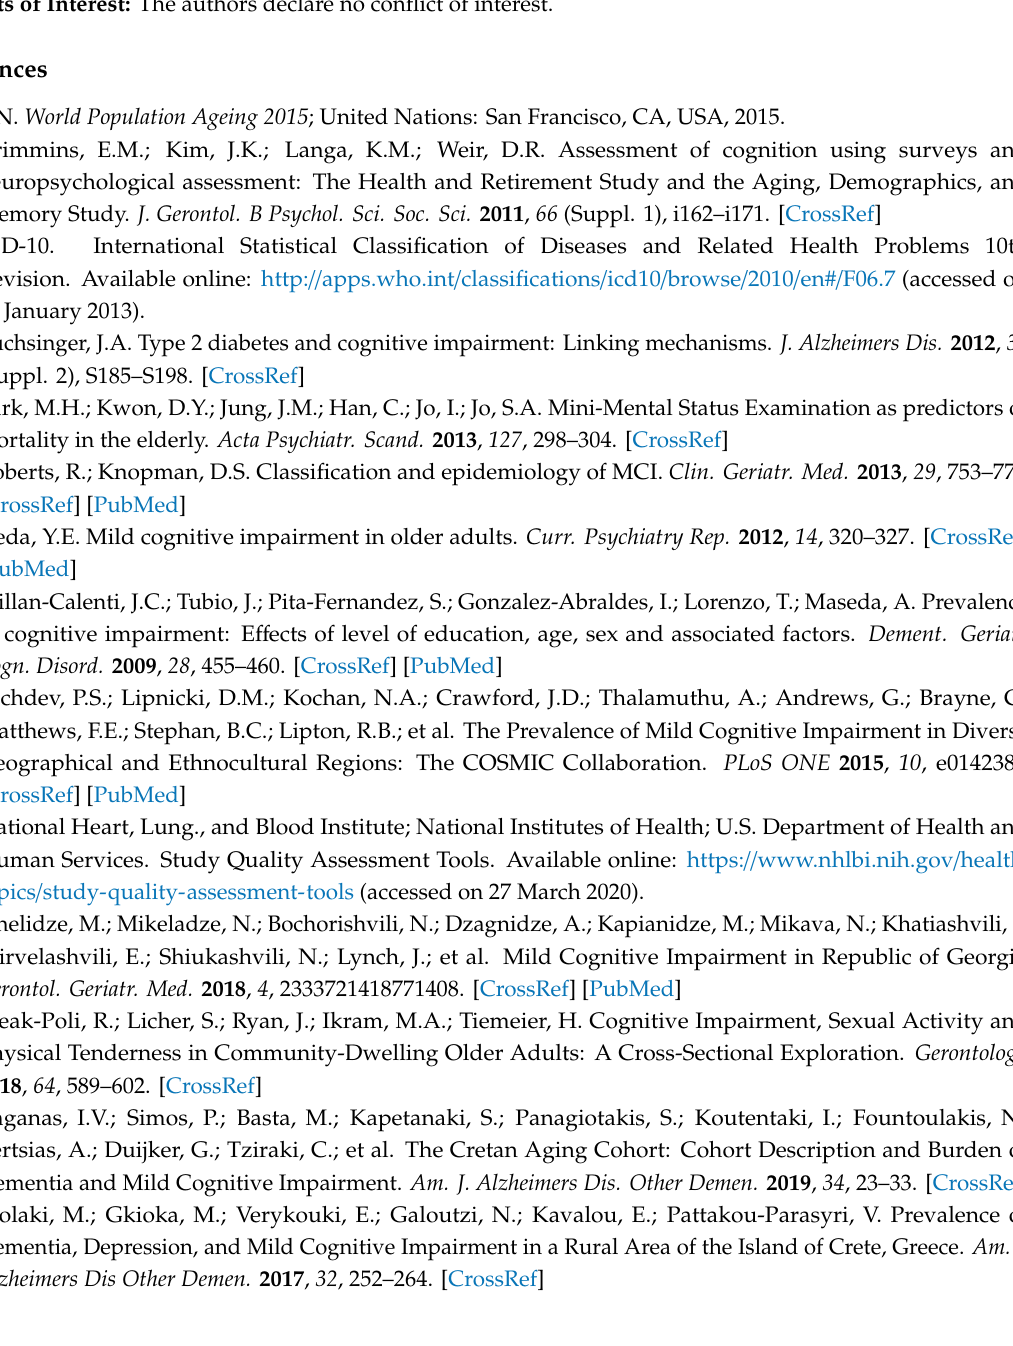
Supplemental Table S1: Cognitive Impairment Crude Prevalence, Supplemental Table S2: Cognitive Impairment Crude Incidence, Supplemental Table S3: Quality Assessment Tool for Observational Cohort and Cross-Sectional Studies; Supplemental Table S4: PRISMA 2009